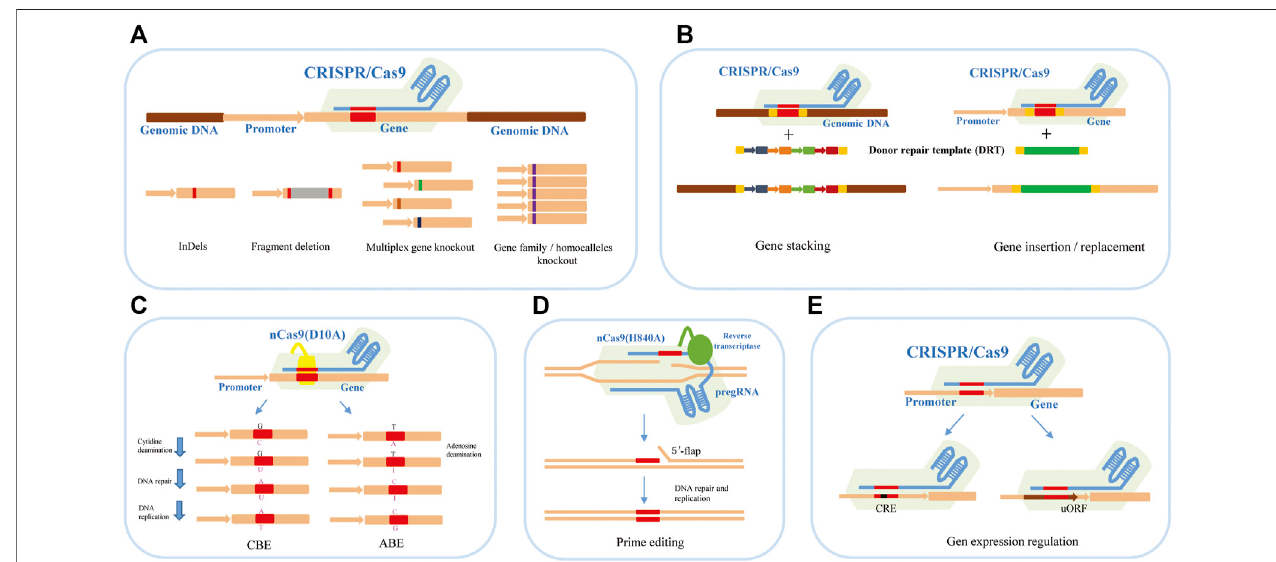
FIGURE 1 | The applications of the CRISPR/Cas9 system in plant genome editing. (A) CRISPR/Cas9-mediated gene knockout can achieve InDels, fragment deletion,and multiplex gene knockout. (B) CRISPR/Cas9-mediatedgeneknock-inand replacementmediated byHDRcan achieve genestackingand gene insertion or replacement to produce new traits in breeding. (C) CRISPR/Cas9-mediated base editing for crop trait improvement including CBE-mediated C-to-T base-editing strategyandABE-mediatedA-to-Gbase-editingstrategy. (D) CRISPR/Cas9-mediatedprimeeditingforcroptraitimprovement. (E) CRISPR/Cas9-mediatedgene expression regulation by editing the cis-regulatory elements and upstream open reading frames